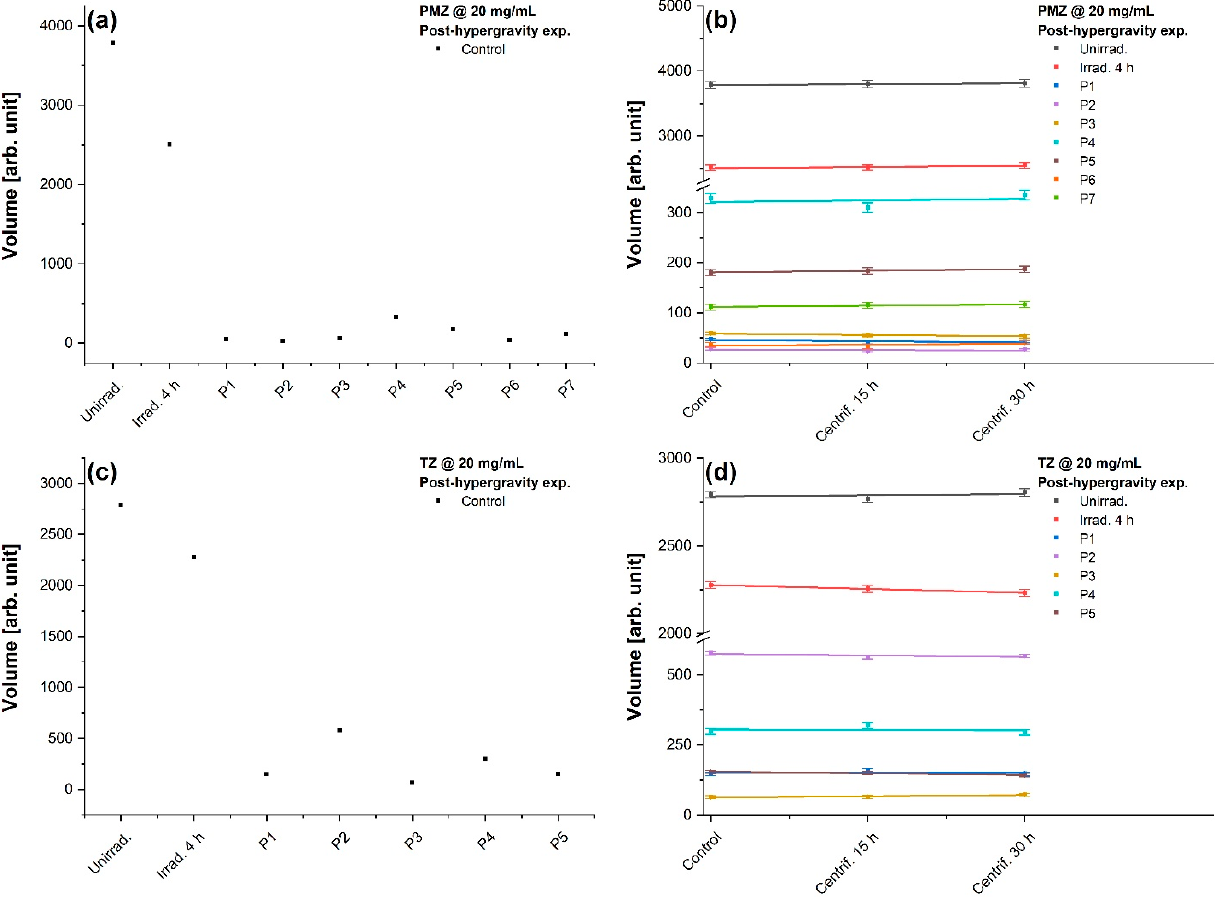
Figure 7. Analysis of TLC plates by JustTLC performed after the hypergravity experiment. ( a ) The volume of PMZ, remaining PMZ after the 4 h laser exposure process, and its seven photoproducts. ( b ) Evolution of uncentrifuged, 15 and 30 h centrifuged PMZ, and its photoproducts volumes. ( c ) The volume of TZ, remaining TZ following 4 h of laser irradiation, and its five generated photoproducts. ( d ) Evolution of TZ and its photoproducts volumes under terrestrial and hypergravity conditions. Error bars: standard deviation.